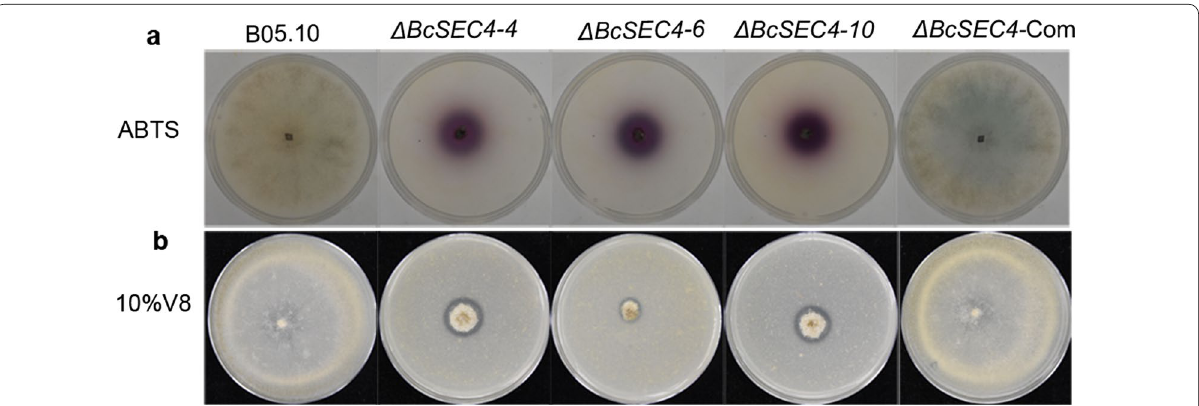
Fig. 4 Deletion of BcSEC4 promotes the secretion of extracellular proteins of B. cinerea . a Laccase activity tested on PDA medium containing ABTS and photographed after 4 days of incubation at 25 °C. b A clear zone formed on 10% V8 medium and photographed after 6 days of incubation at 25